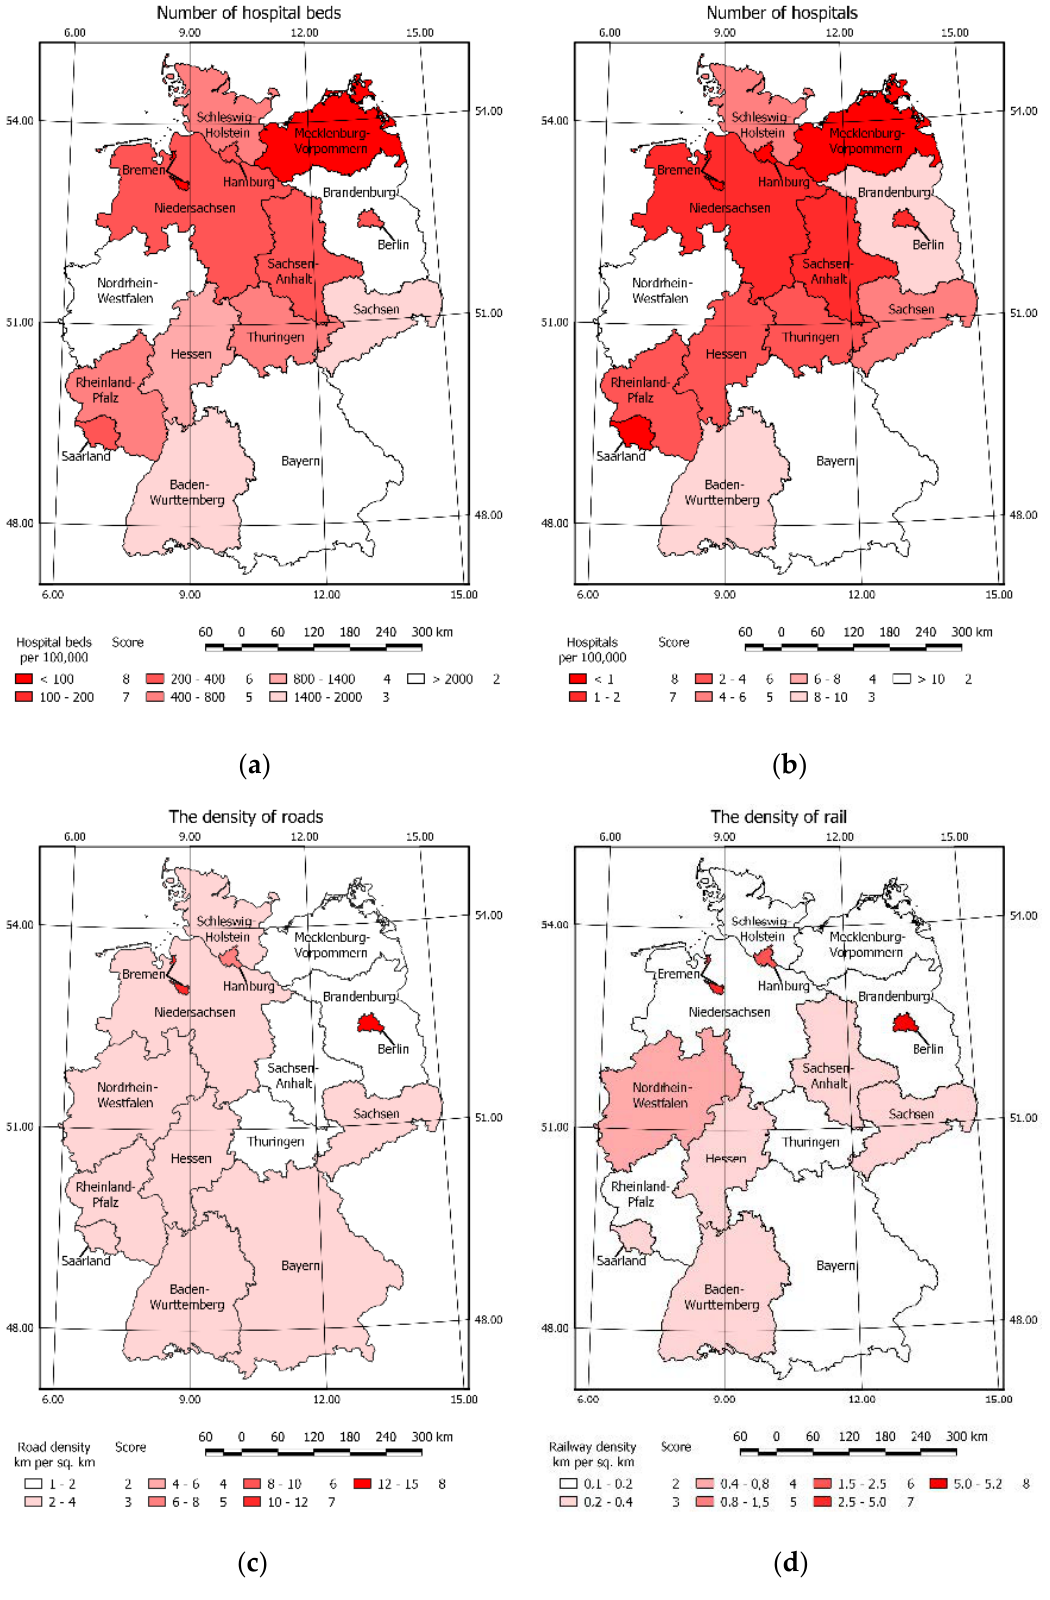
Figure 6. Maps of VSc for selected static criteria on 12 May 2021 ( a ) number of hospital beds ( b ) number of hospitals ( c ) density of roads ( d ) density of railways.